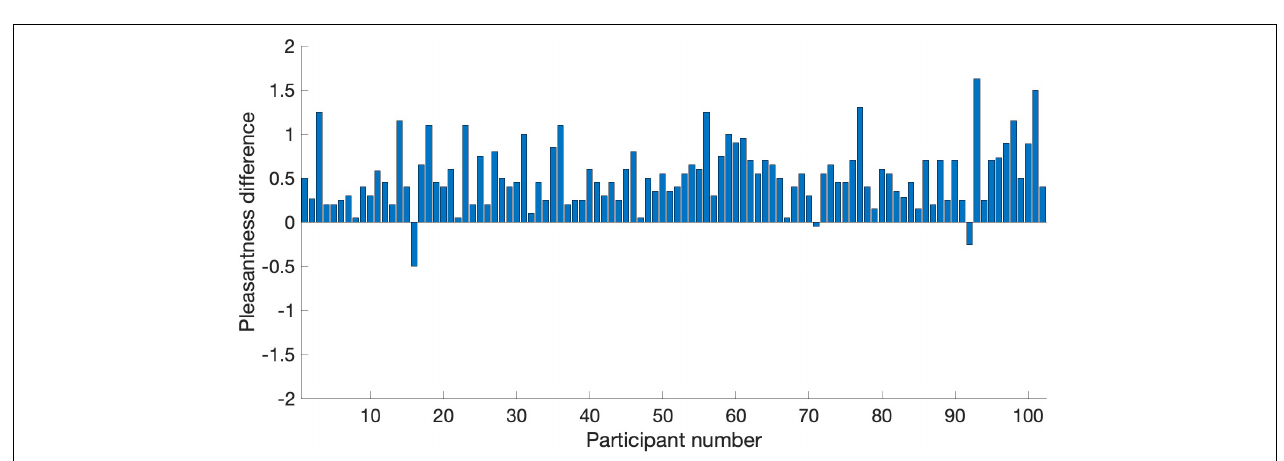
FIGURE 5 | Pleasantness difference scores (PAVS rating minus OVS rating) for the 102 participants in Study 3. Each bar represents the average difference score across the 20 PAVS and 20 OVS for each